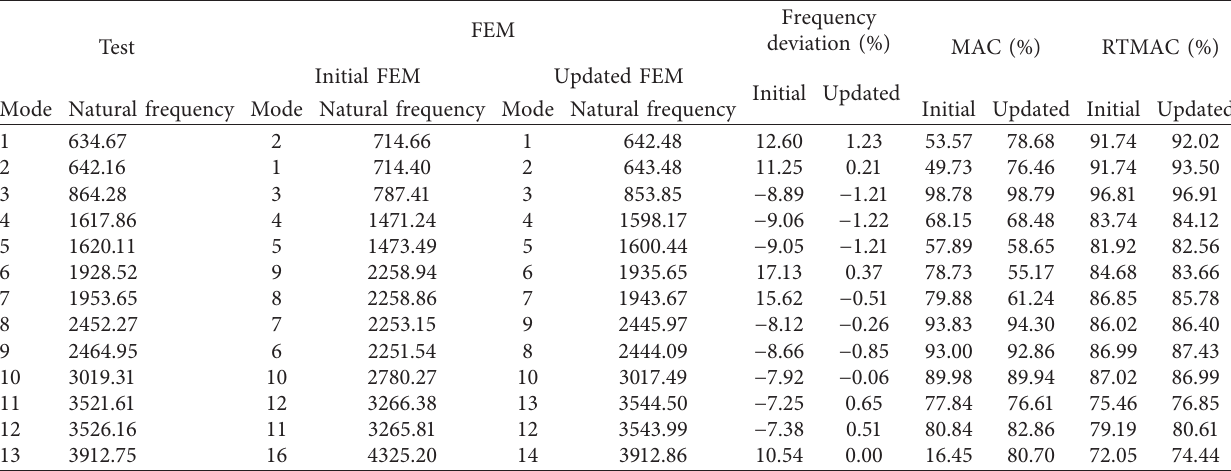
Figure 26: Correlation analysis using RTMs between the test and the FE model after updating. Table 9: Frequency deviation and RTM correlation values before and after model